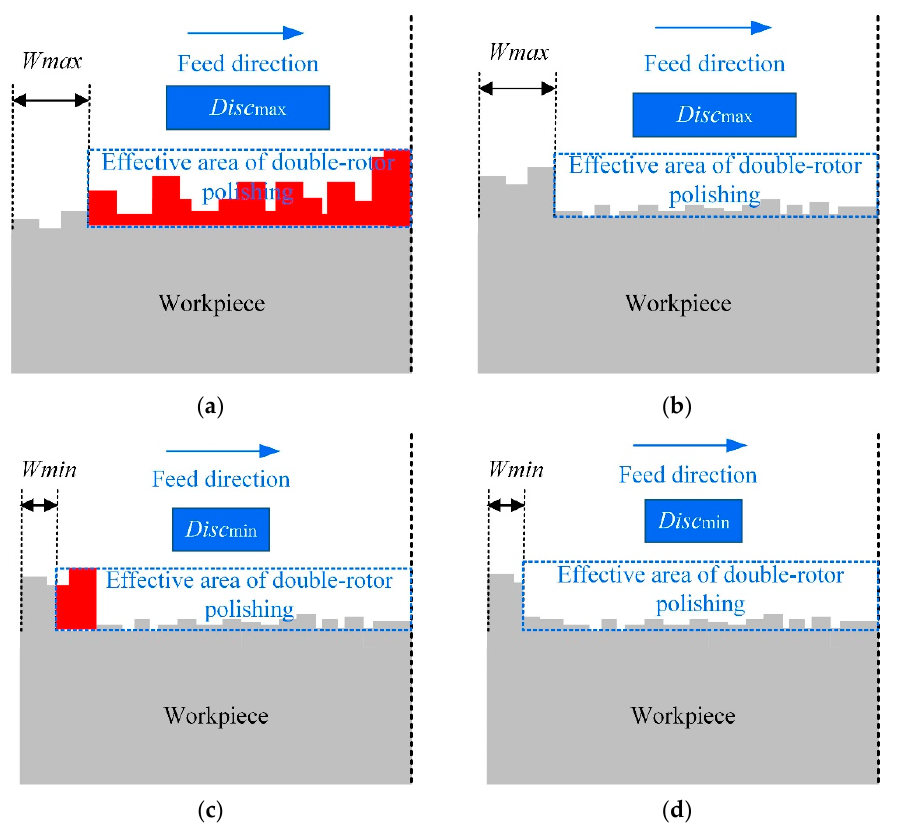
Figure 4. Edge removal theory of double-rotor polishing. ( a ) initial surface profile and area to be removed for the first time, ( b ) surface profile after polishing with a large tool, ( c ) area to be removed for the second time, ( d ) surface profile after polishing with a small tool.